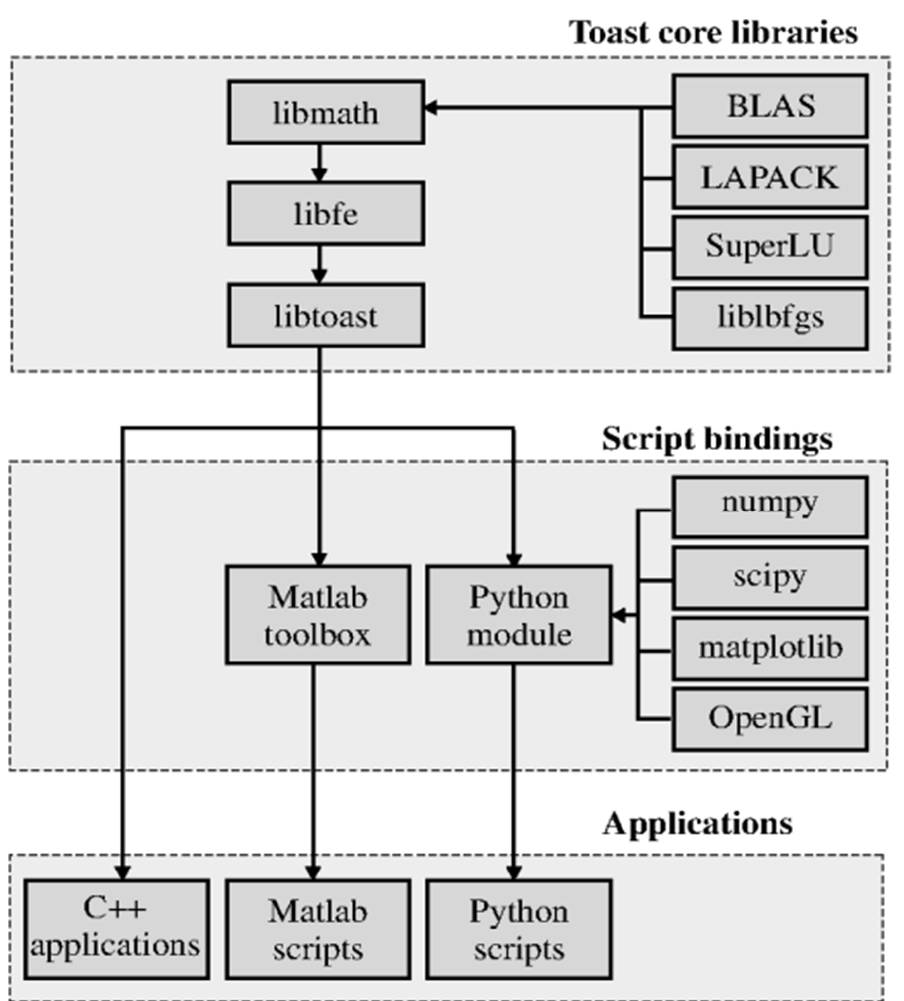
Figure 5. Libraries for Toast++ technique for forward model simulation (adapted from Ref [55]).